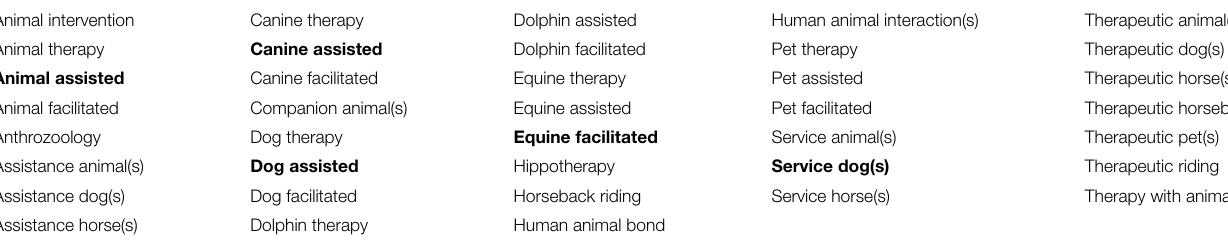
TABLE 1 | List of terms to identify Animal-Assisted Intervention (AAI) in database search. Animal intervention